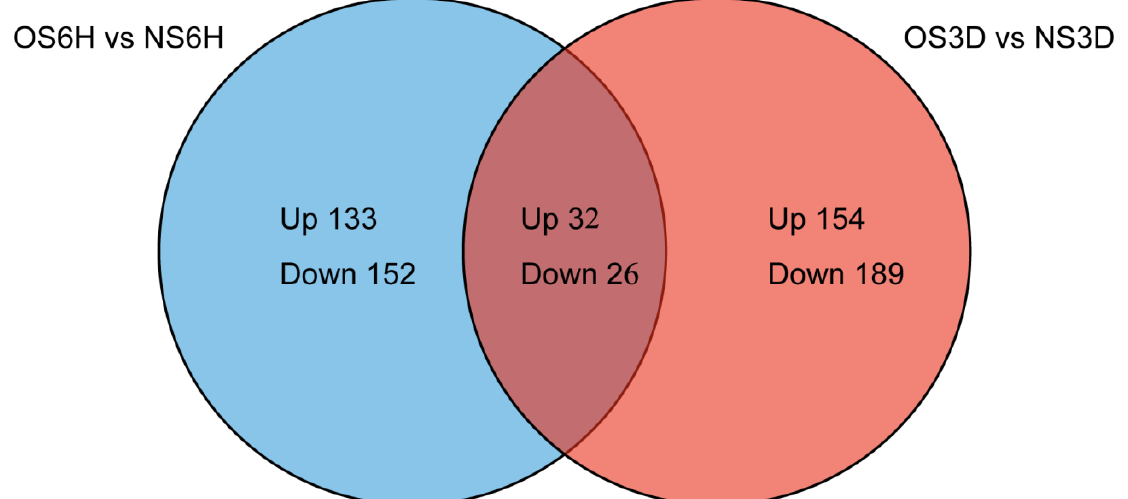
Figure 2. Graphical representation and functional cataloging of DAPs. The Venn diagram presents the number of significantly upregulated and downregulated proteins in pitaya under the drought-stress conditions induced by PEG.